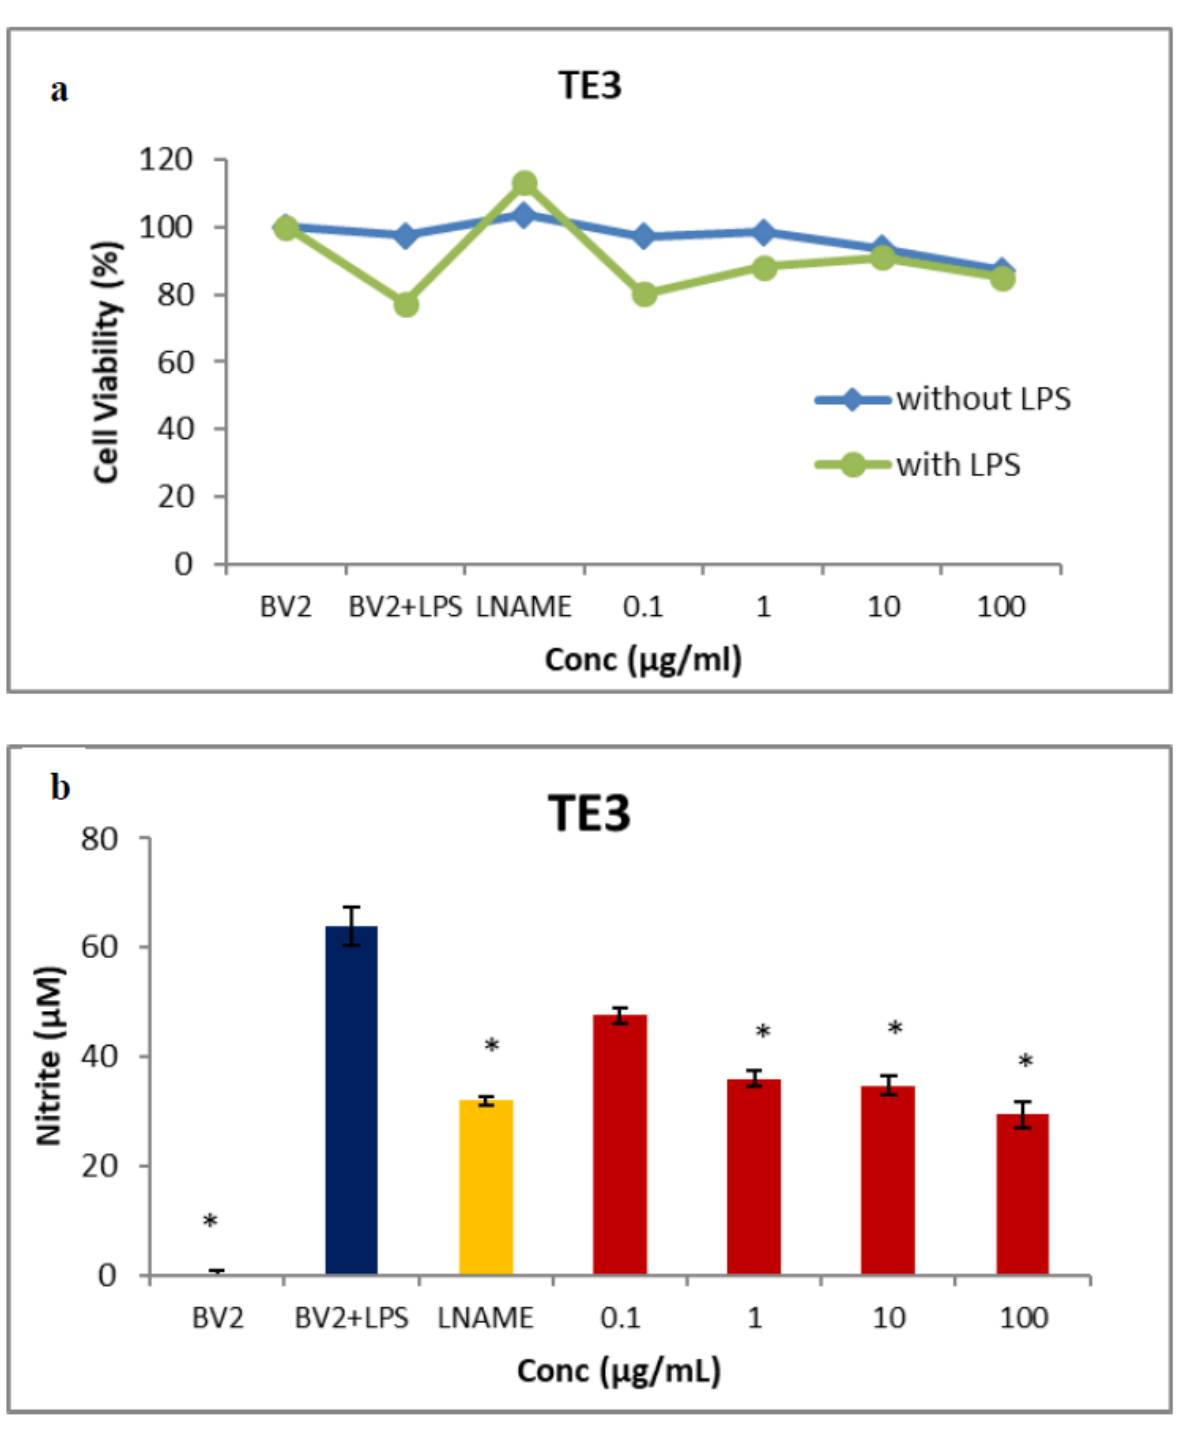
Figure 1 - The effect of treatment with the TE3 fraction of L. rhinocerotis on (a) BV2 cell viability and (b) nitrite production in BV2 cells. The * symbol denotes a significant difference (p < 0.05) from the corresponding value of the control. L-NAME= N( ω )-nitro-L-arginine methyl ester (200